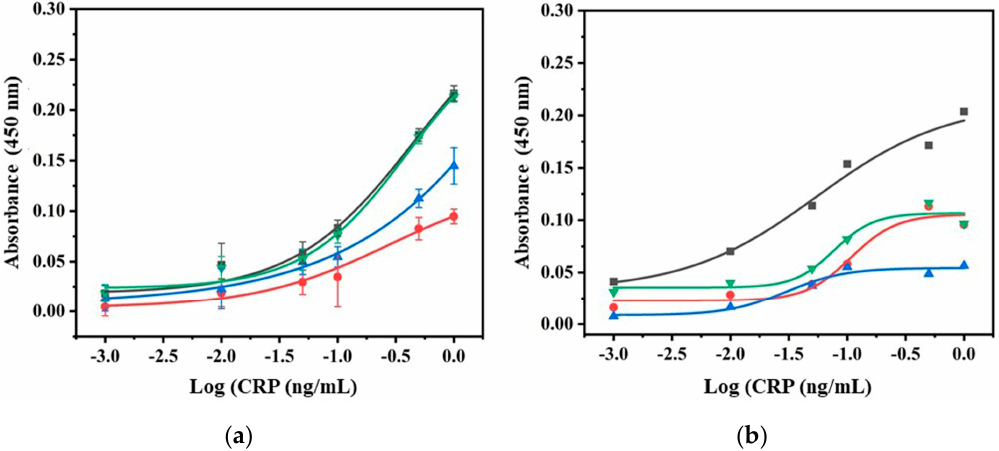
Figure 2. Graphical representation of peptide (6XHis) density estimation conjugated on the surface of gold nanoaprticle. Each data point (black dots) represent the error bar, obtained from three sets of experiments.